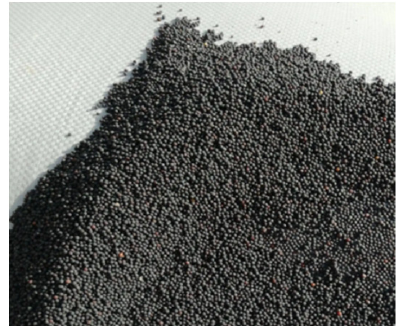
Figure 1. Rapeseed (Brassica). It is the seed of the rapeseed.of the cruciferous crop. The rapeseed is spherical or ellipsoid and is mainly used for oil extraction.